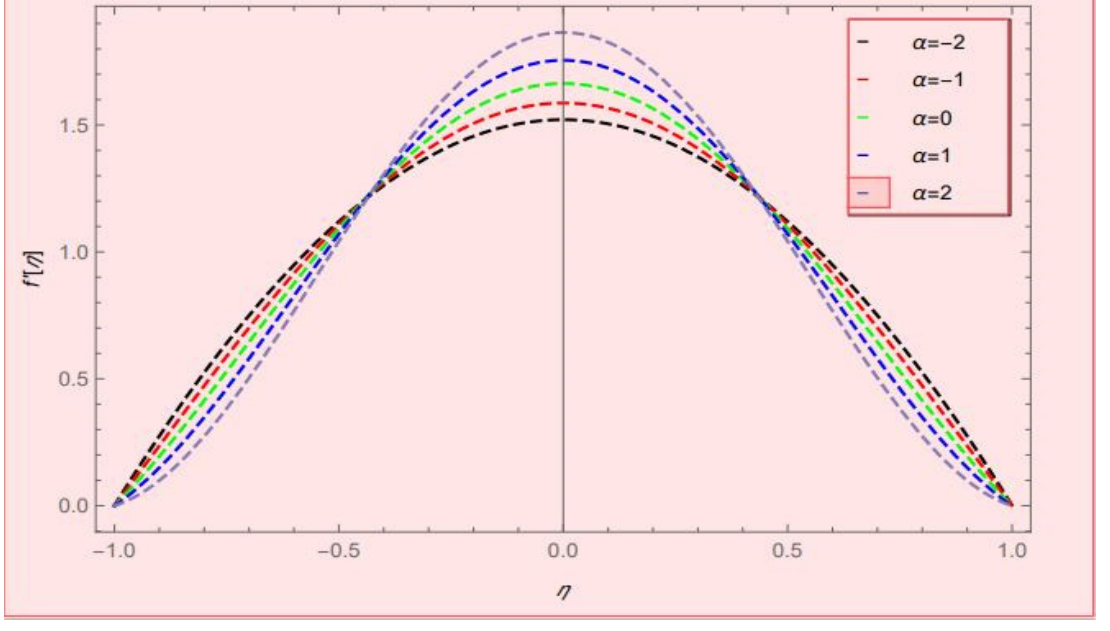
Figure 4. Influence of the volume fraction on the heat transfer rate of nano and hybrid nanofluids.